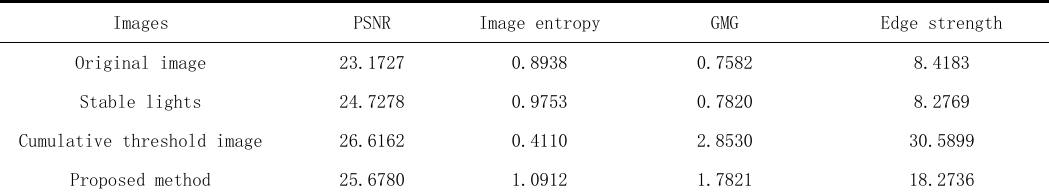
Figure 1. DMSP/OLS average light image deblurring Table 1. Deblurring